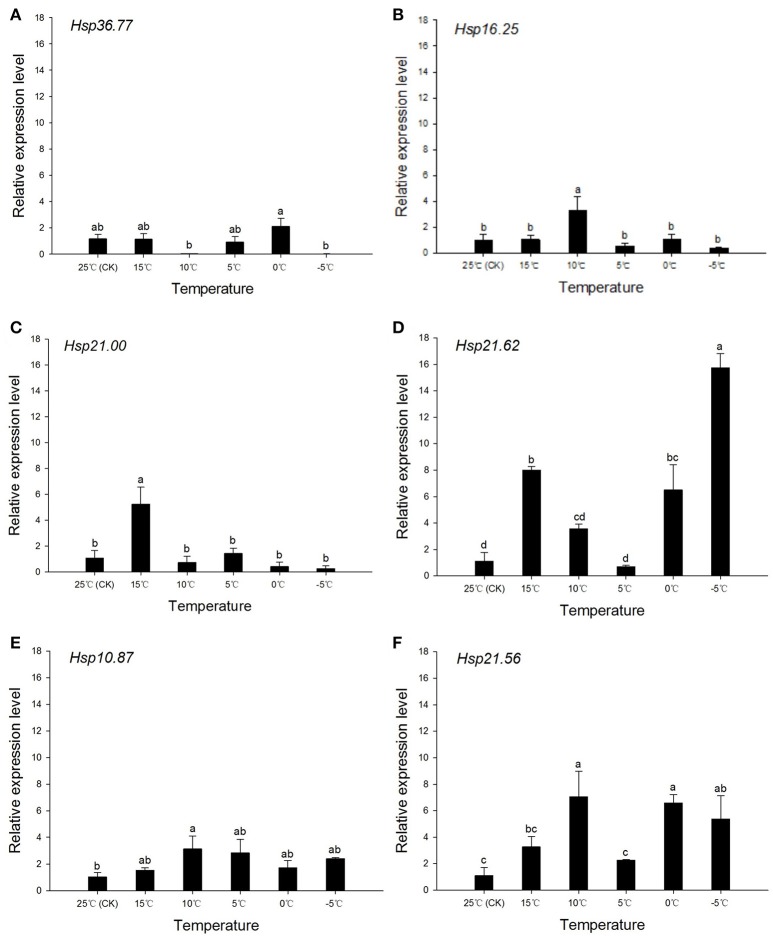
Relative expression of Harmonia axyridis sHSPs under the short-term cooling treatment. Experimental population is used for this trial. (A)
Hsp36.77. (B)
Hsp16.25. (C)
Hsp21.00. (D)
Hsp21.62. (E)
Hsp10.87. (F)
Hsp21.56. Expression of sHSPs was examined in a gradually cooled environment, from 25 to −5°C.During the cooling process, the control group (CK) comprised adults reared at an optimum temperature (25°C) without any cold stimulation. Data are presented as means ± s.d. (n = 3). Bars with different letters indicate significant differences (P < 0.05) and used Tukey's test, α = 0.05, a > b > c > d.